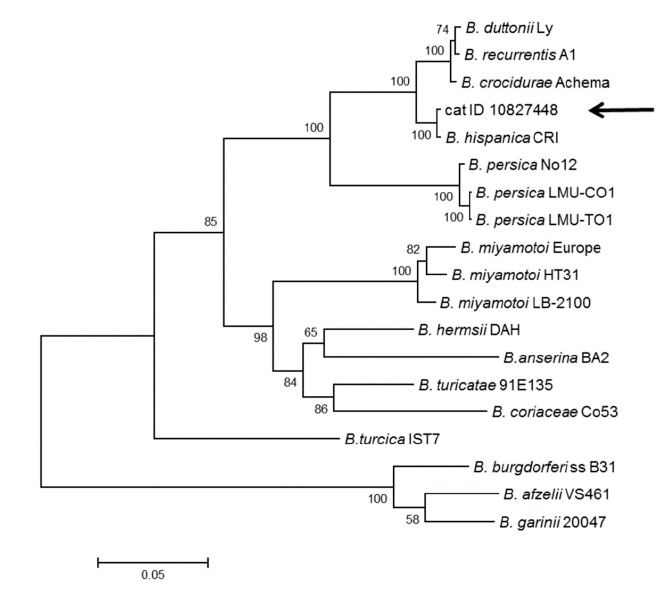
Figure 2. Molecular phylogenetic analysis by the maximum likelihood method based on the sequences of four housekeeping loci ( clpX, pepX, pyrG , and recG ). The tree with the highest log likelihood ( − 13,651.6897) is shown. The bootstrap value (percentage of trees in which the associated taxa clustered together) is shown next to the branches. The tree is drawn to scale; scale bar = number of substitutions per site. The analysis involved 19 nucleotide sequences. There were a total of 2443 positions in the final dataset.